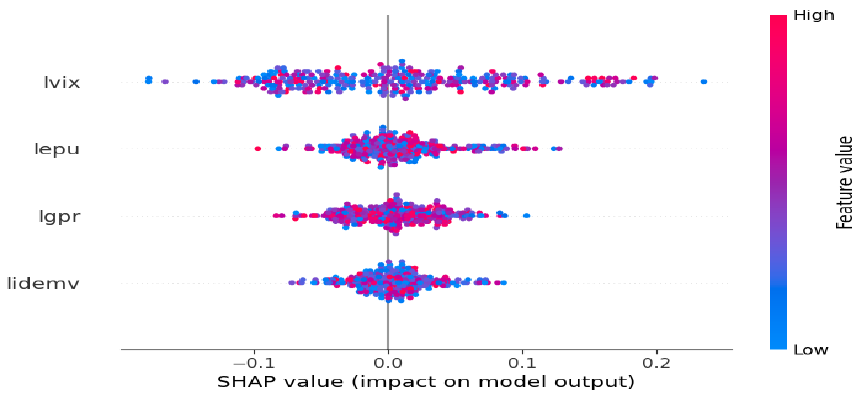
Figure 8. Feature importance before the pandemic—XGBoost model (Daily frequency).